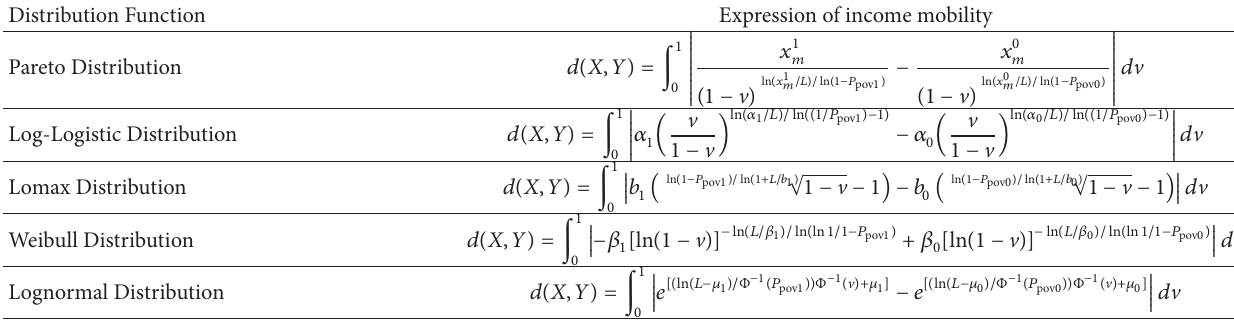
Table 4: Relationships between poverty ration and income mobility of the five Distribution